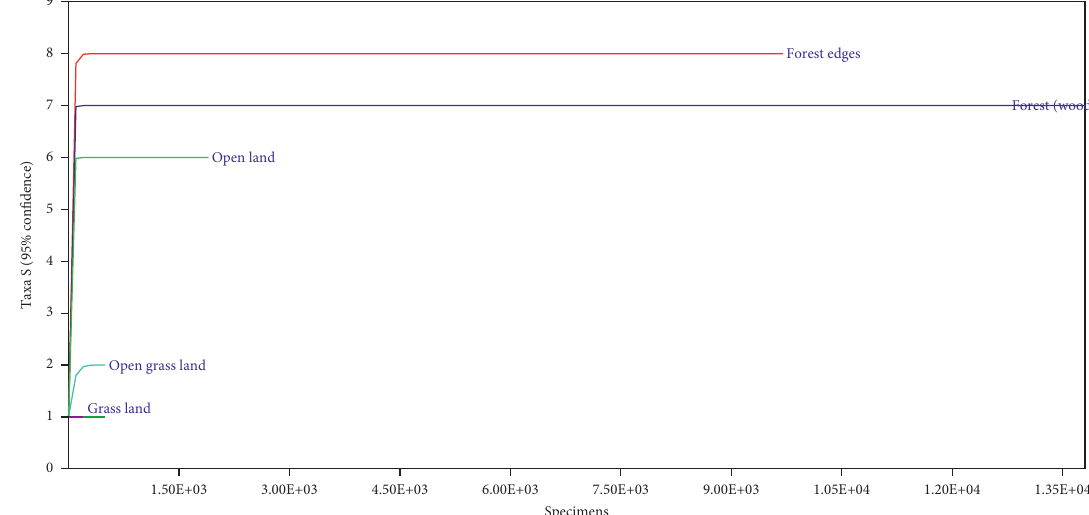
Figure 8: Sample based rarefaction curves of estimated butterfly species richness at five different habitats in the Upper Blue Nile basin, Amhara Region,